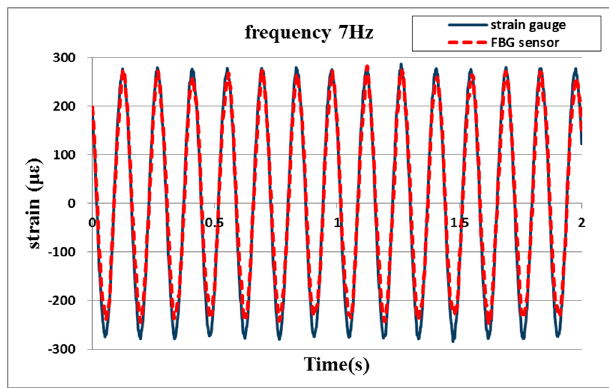
Figure 8. Vibrational response of a cantilever beam subjected to single frequency base Figure 8 . Vibrational response of a cantilever beam subjected to single frequency base excitation .